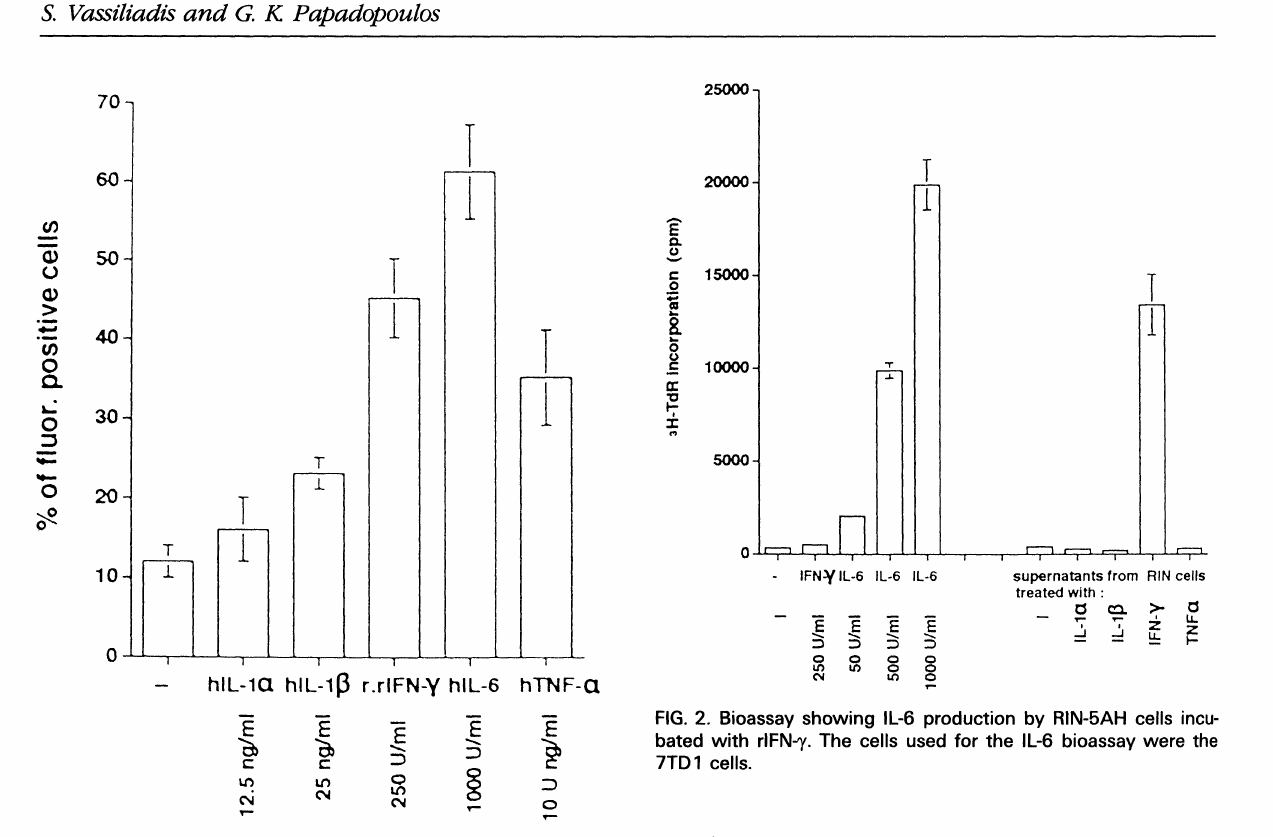
FIG. 1. Induction of MHC class II antigens on the surface of RIN- 5AH cells after 48h treatment with specific recombinant cyto- kines, at the stated doses. Expression was monitored via a fluor- escent monoclonal anti-rat class II antibody (see Materials and Methods).